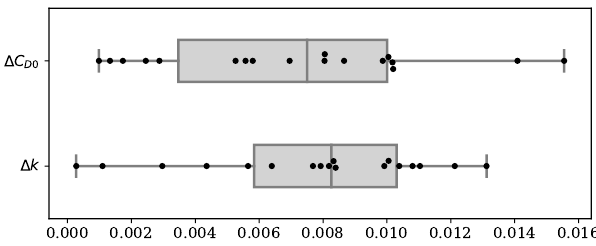
Figure 11. Absolute difference of drag polar between BADA (3.12) and the model derived in this paper under clean configuration.